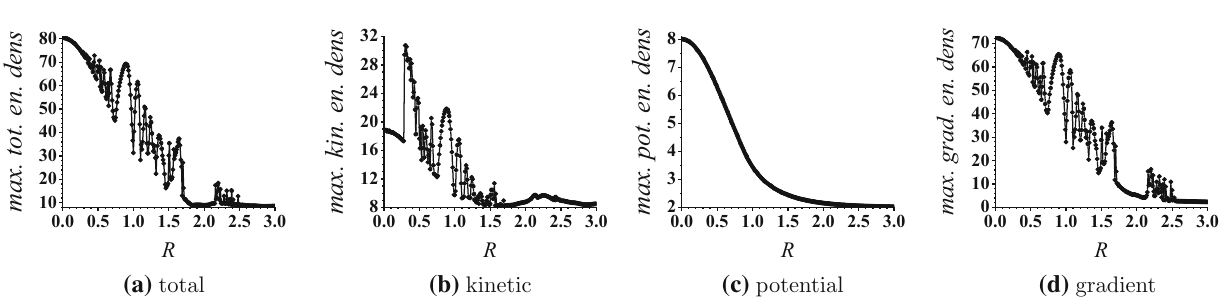
Fig. 9 Space-time picture of collisions of three kinks for different R ’s